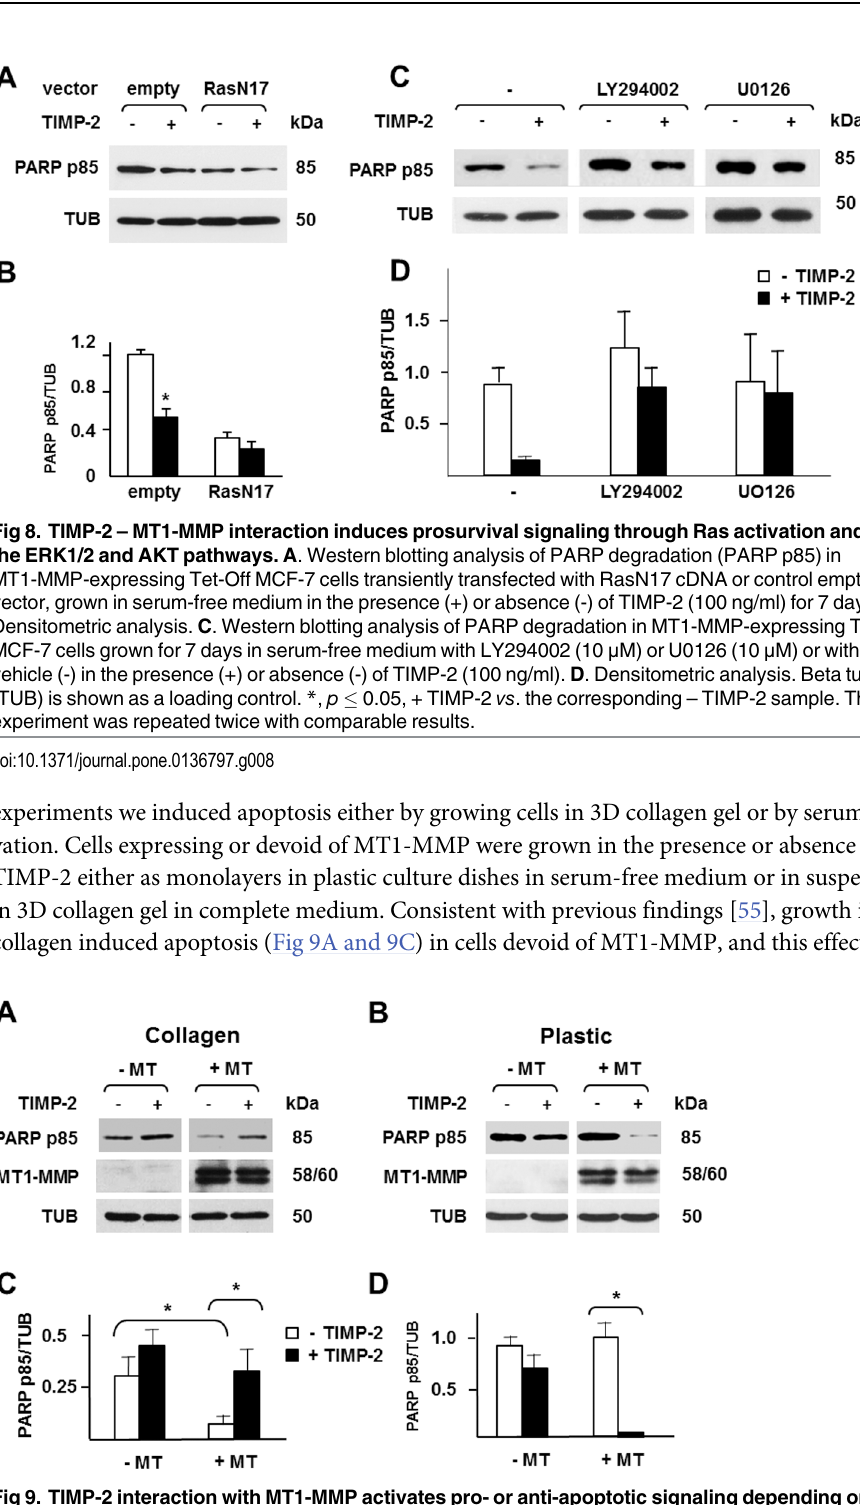
Fig 9. TIMP-2 interaction with MT1-MMP activates pro- or anti-apoptotic signaling depending on context. Western blotting analysis of PARP degradation (PARP p85) and MT1-MMP expression in MT1-MMP Tet-Off MCF-7 cells grown for 7 days in ( A ) 3D collagen gel or ( B ) on plastic, in the presence (-MT) or absence (+MT) of DOX with (+) or without (-) TIMP-2 (100 ng/ml). Beta tubulin (TUB) is shown as a loading control. C and D . Densitometric analysis. * , p (cid:1) 0.05. This experiment was repeated twice with comparable